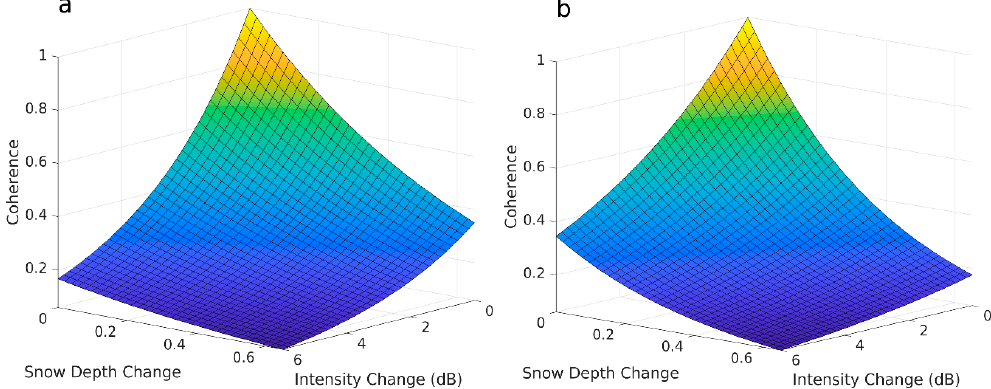
Figure 9. Coherence curves of forested ( a ); and shrub ( b ) land cover types. Table 3. Statistical properties, i.e., mean and standard deviation (SD), of interferogram categories. The